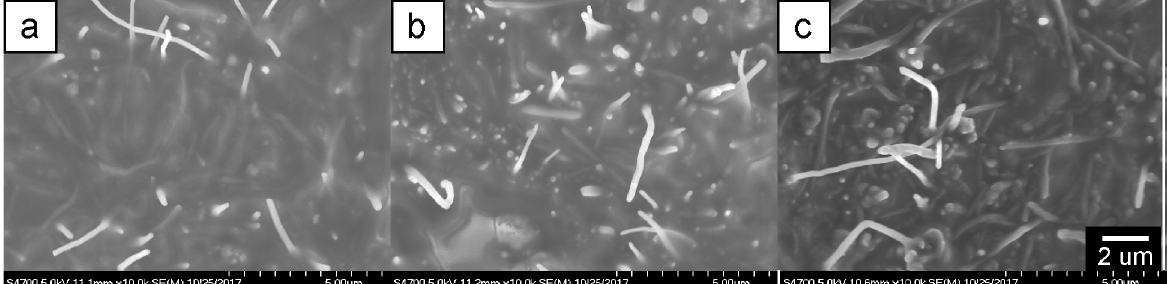
Fig 2. SEM images of representative cryo-fracture surfaces for a) 3 vol %, b) 4 vol %, and c) 7 vol % CNF loadings.